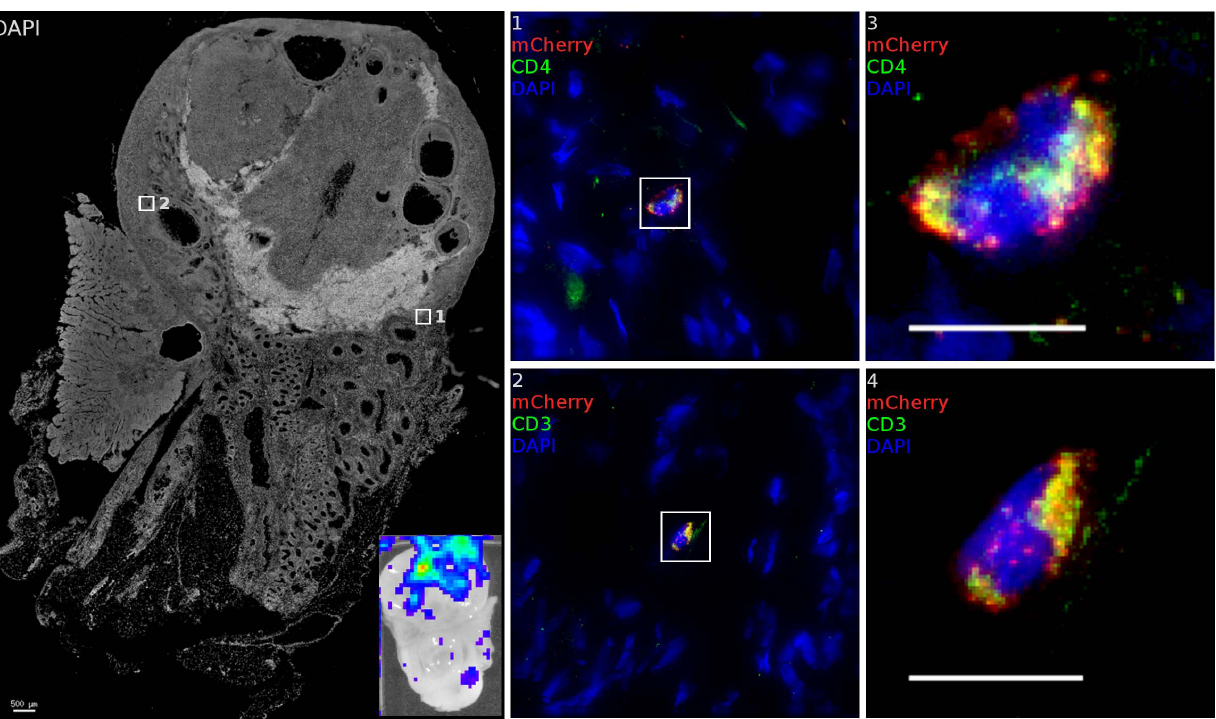
Figure 7. The ovary is susceptible to infection. After inoculation with JRFL pseudotyped LICh vector, tissues demonstrating luminescent signal (inset) is stained for luciferase and CD3 or CD4. Inset shows luciferase expression within tissue before freezing. Transduced cells within each region are shown as numbered close-up. Infected cells are found within the cortical zone of the ovary. Infected cells are not found within developing ova. The cell in region 1 and 3 expresses HIV-1 receptor CD4. Staining the adjacent tissue section identifies the transduced cell in region 2 and 4 as being